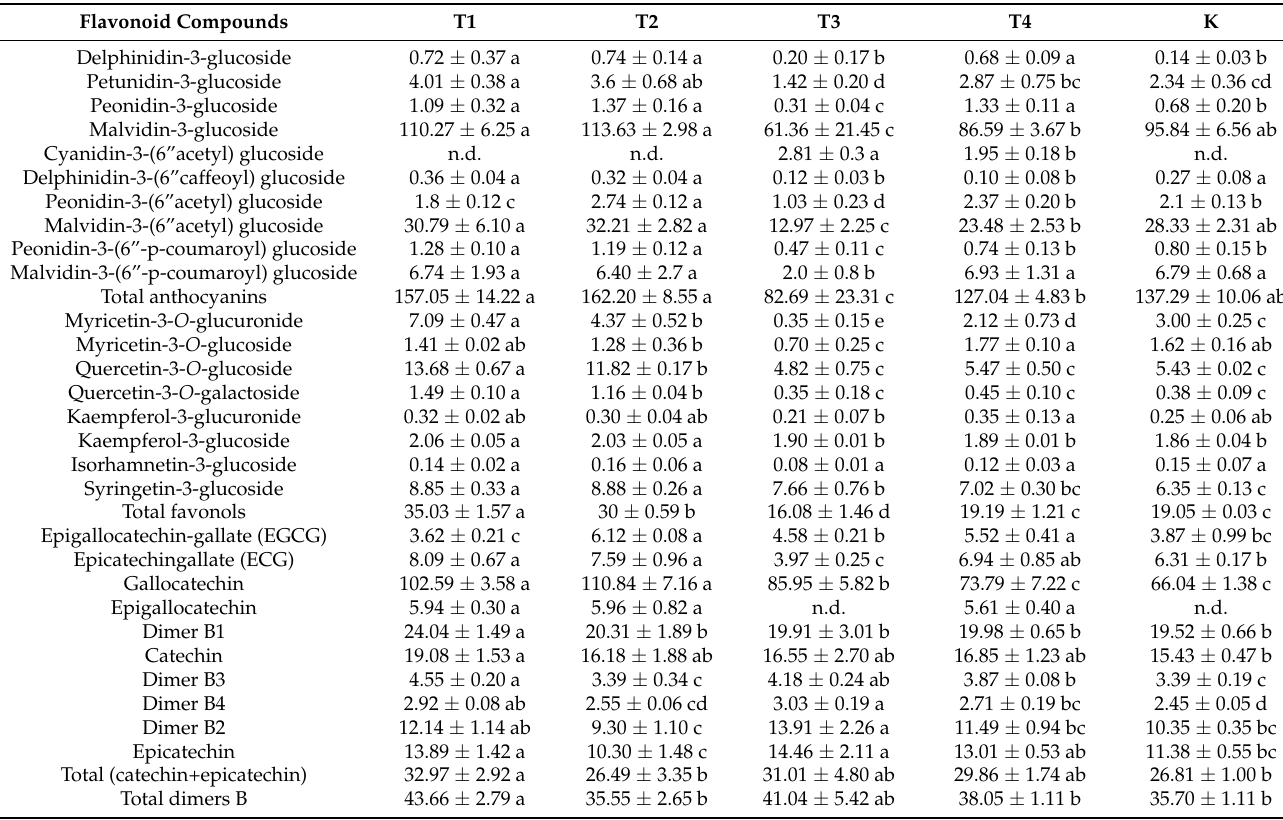
Table 4. Effects of fruit zone leaf removal: preflowering (T1), after berry set (T2), at veraison (T3), cluster thinning without defoliation in veraison (T4) and untreated control (C) on the concentration of flavonoid polyphenolic compounds in Trnjak wines